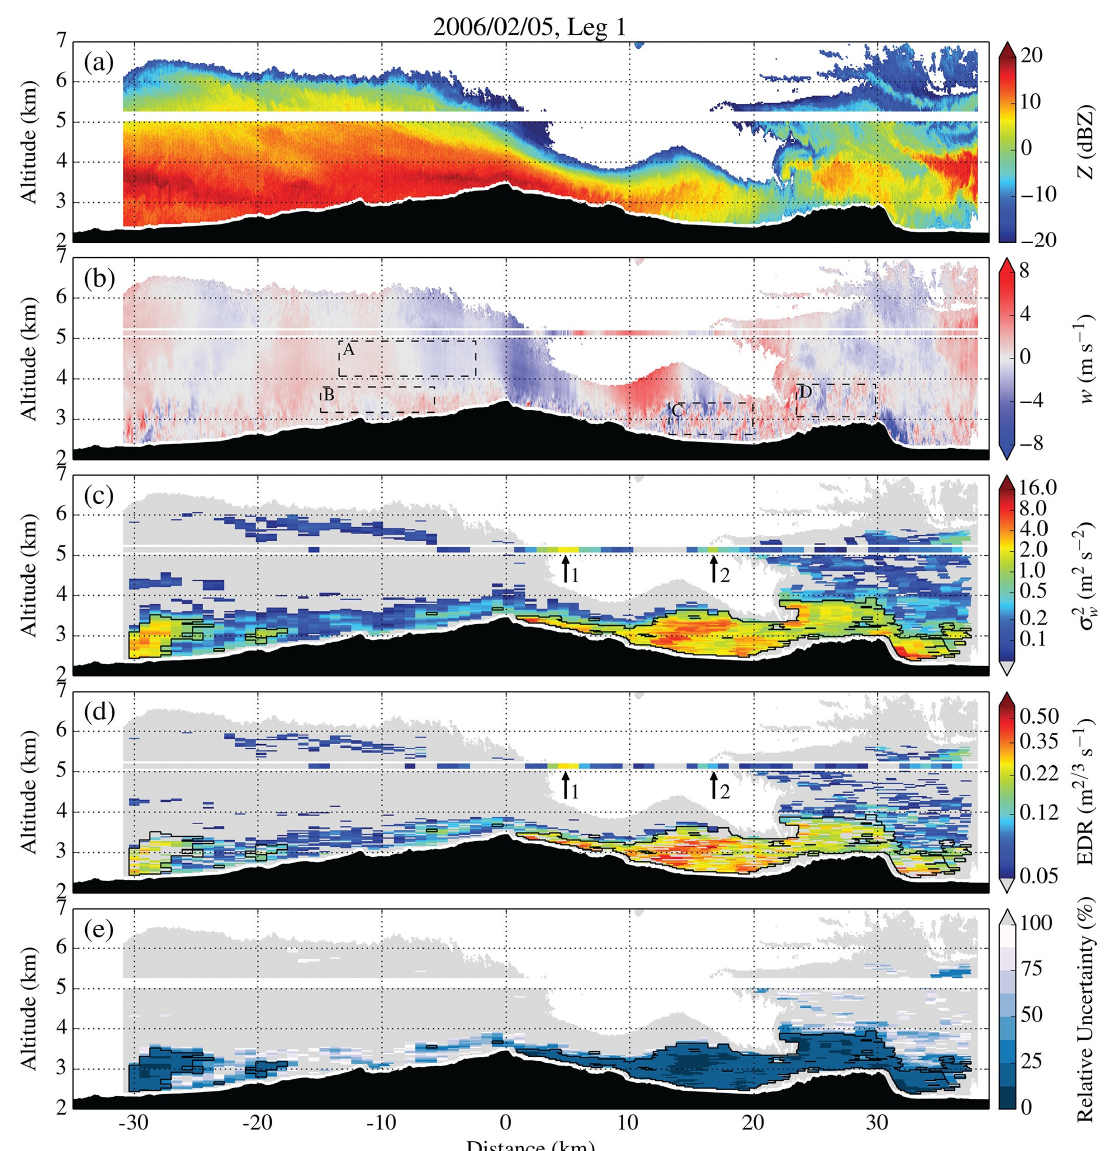
Figure 7. Radar data and derived turbulence parameters along a cross-mountain leg on 26 January 2006 at ~5200 m above sea level (ASL) in a flight across Medicine Bow Mountains (Wyoming, USA). ( a ) Radar reflectivity Z, ( b ) vertical Doppler velocity w, ( c ) variance of vertical velocity σ w 2 , ( d ) eddy dissipation rate estimated using vertical velocity, EDR w , and ( e ) relative uncertainty of the estimate. The black contour in ( c – e ) marks the region, in which the relative uncertainty of the σ w 2 estimate is lower than 25%. Arrows in ( c , d ) indicate local maxima in σ w 2 and EDR.